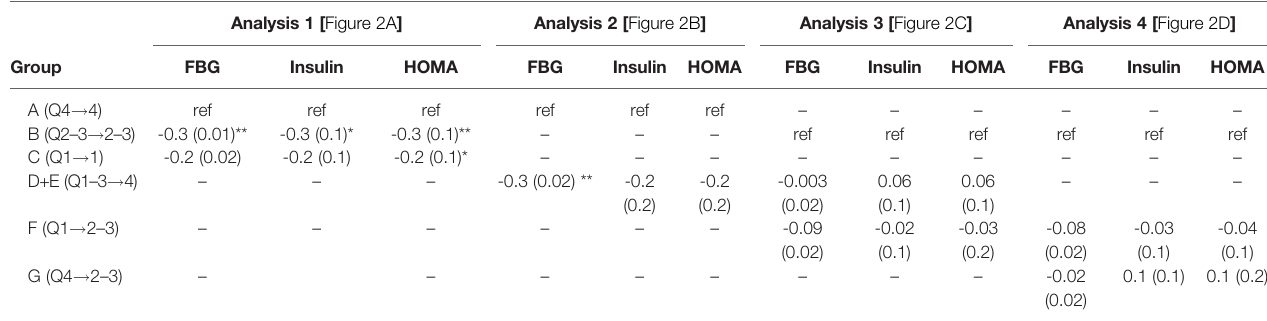
TABLE 3 | Regression analysis of FBG, insulin, and HOMA-IR according to BMI Z-score change group. Analysis 1 [ Figure 2A ]